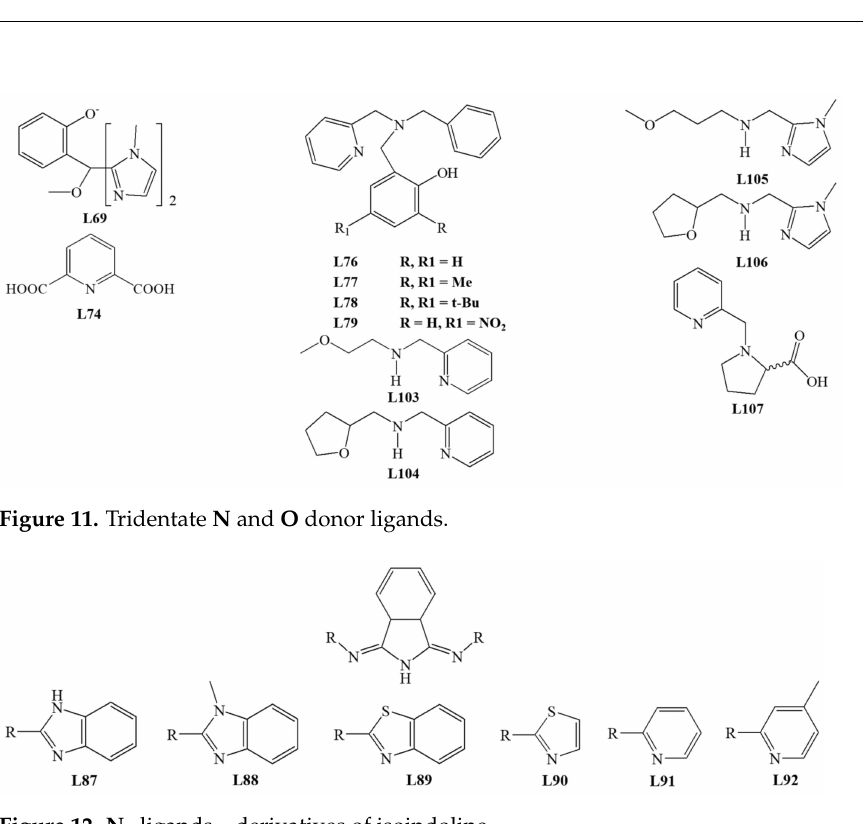
Figure 12. N 3 ligands—derivatives of